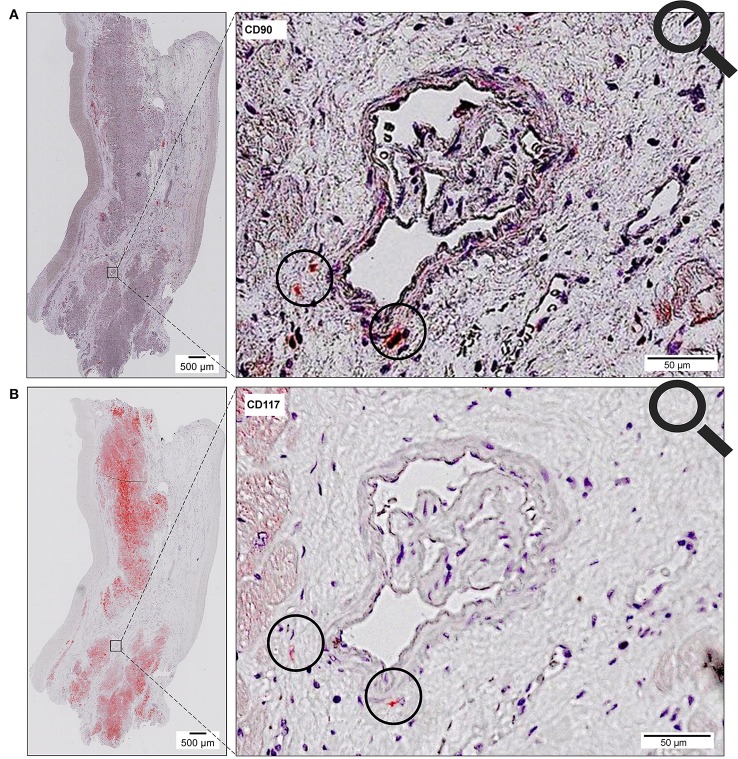
Coexpression of CD90 and CD117. Two serial sections of the same patient (Patient 4) are stained with different antibodies (A, CD90; B, CD117). The circle shows cells with co-expression of both stem cell markers (CD90+ on 1st slide, CD117+ on 2nd slide).